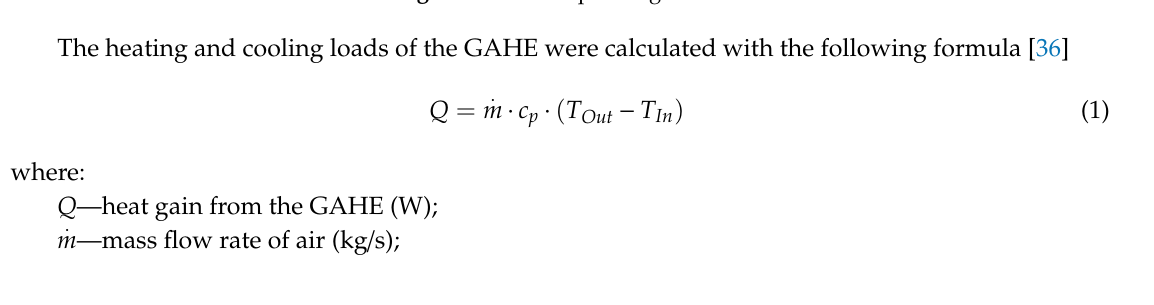
Figure 2. GAHE operating time.